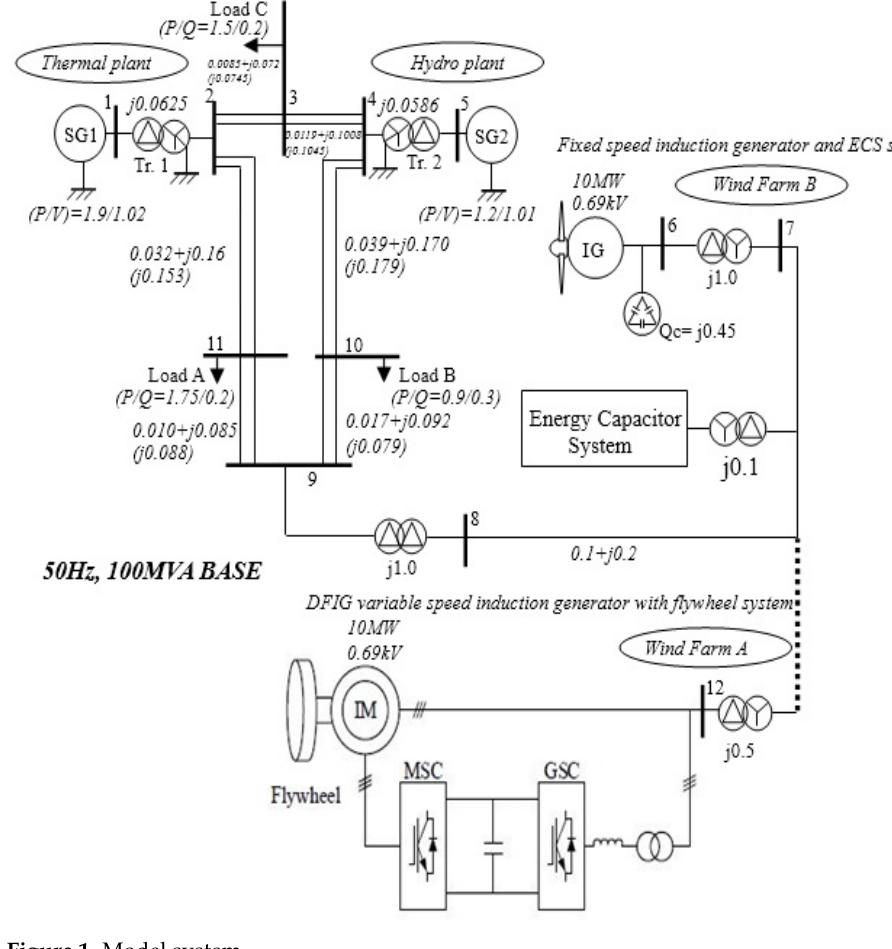
Figure 1. Model Figure 1. Model system. Table 1. Generator Parameters [39].